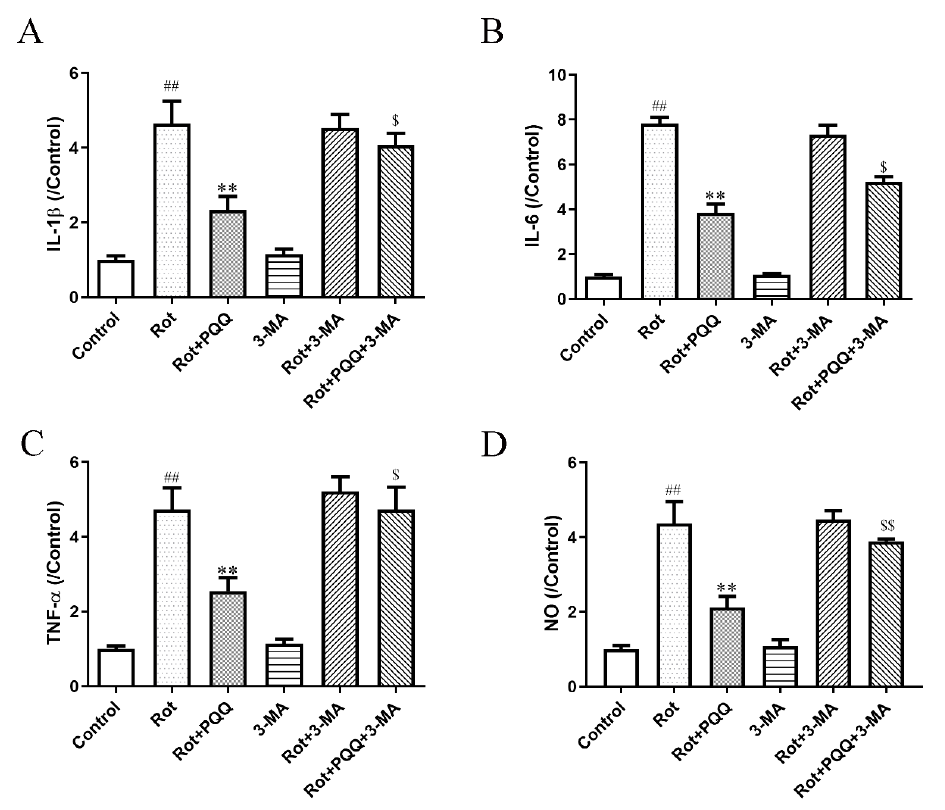
Figure 5. Autophagy inhibitor prevented the induction of pro-inflammatory cytokine and NO release induced by rotenone in BV2 microglial cells. 3-MA was applied to the BV2 cells at the concentration of 3 mM 1 h before 10 µ M PQQ treatment and 1 µ M rotenone stimulation for 12 h. The levels of IL-1 β ( A ), IL-6 ( B ) and TNF- α ( C ) in the cultured media were measured by ELISA assays. ( D ) NO release in the cultured medium was measured. The data were presented as the mean ± SEM from four independent experiments. ** p < 0.01 vs. rot group; ## p < 0.01 vs. control group; $ p < 0.05, $$ p < 0.01 vs. Rot+PQQ group.